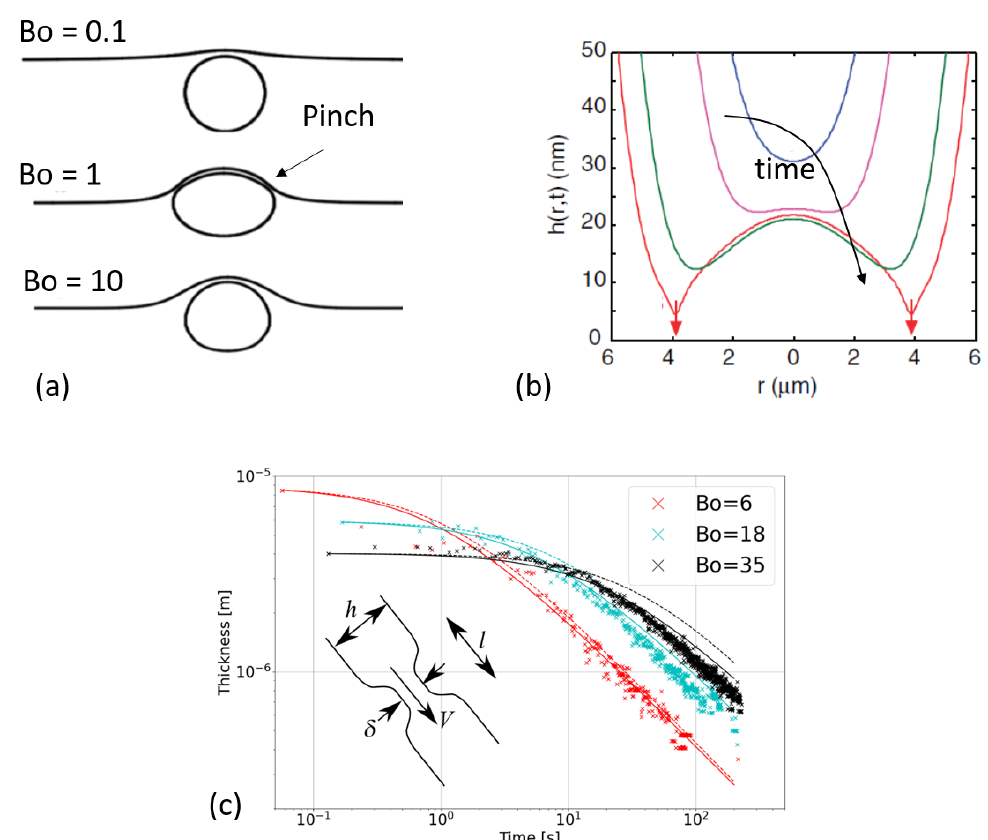
Figure 4. ( a ) Scheme adapted with authorization from reference [17]. From top to bottom, shape of bubbles at increasing Bond numbers in presence of some surfactants. For intermediate Bond numbers, a pinch appears, which leads to a drastic increase of the bubble lifetime. ( b ) Prediction of the thickness profile of the film during a bubble-bubble approach. r is the radial coordinate with its origin on the vertical axis of symmetry of the two approaching bubbles. A pinch appears and thins along time. Image adapted with authorization from reference [36]. ( c ) Comparison of the thickness of the film at the top of bubble with the model proposed by Lhuissier [21] (dashed lines) complemented by a gravity-driven drainage (solid lines) for bubbles of different radius R . The inset represents a sketch of the pinch in the vicinity of the meniscus, close to the bath. Figure adapted from reference